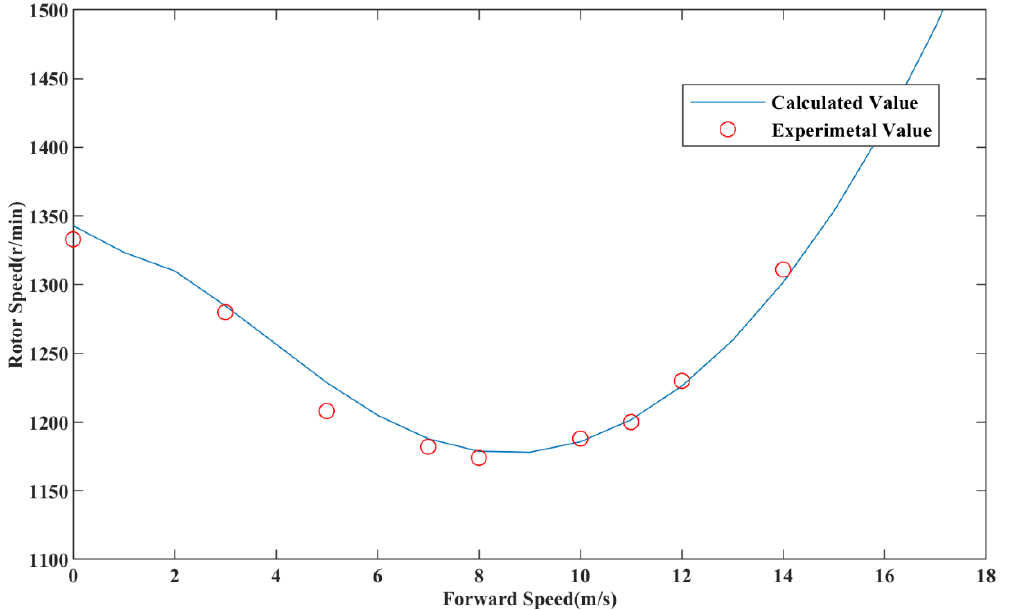
Figure 2. Variation of rotor speed of trim with the increasing forward flight speed compared (calculated value) to the actual rotor speed of the verification aircraft (experimental value).